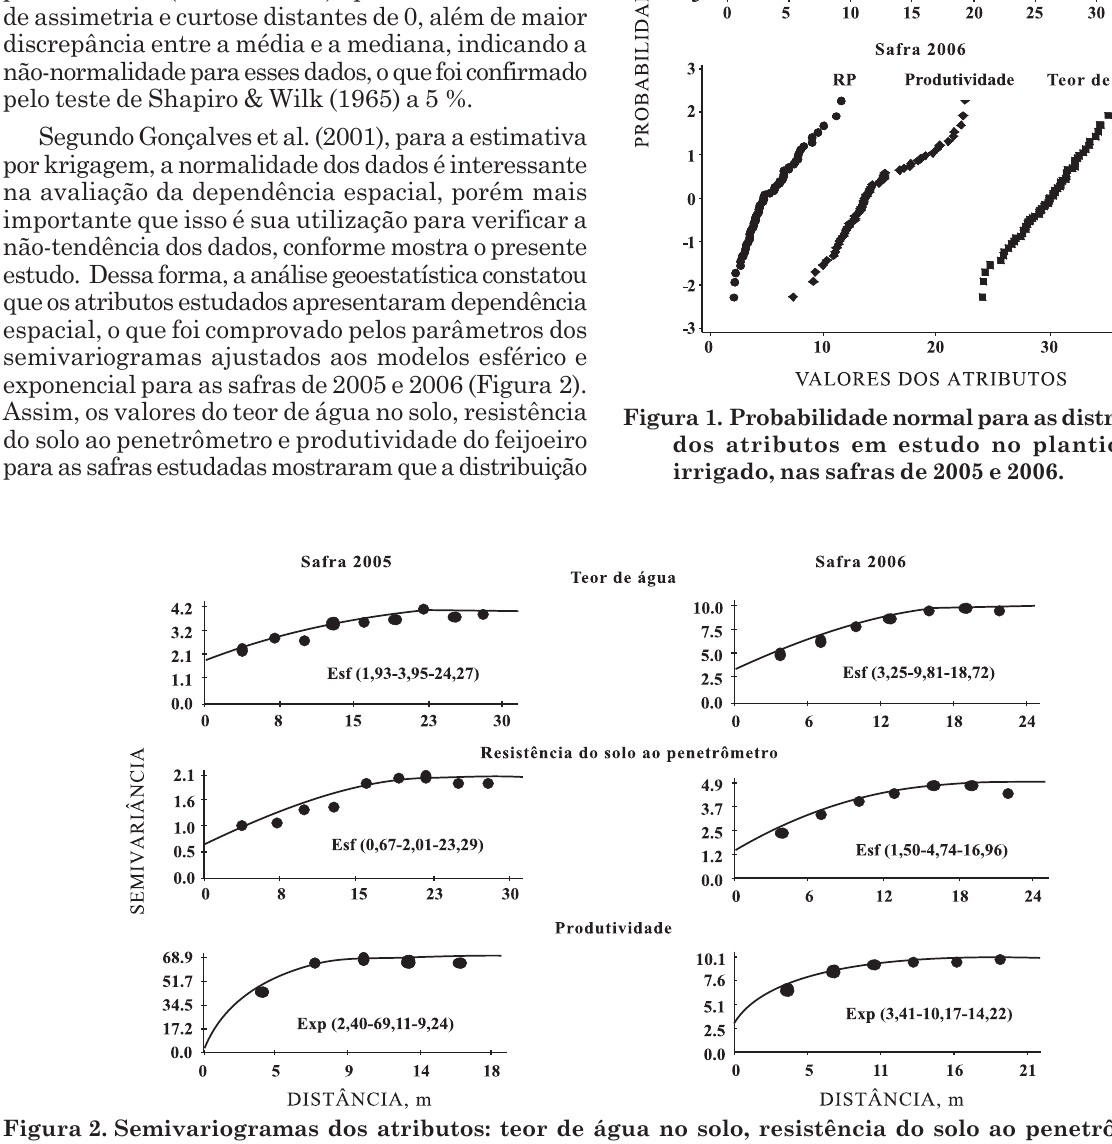
: efeito pepita; C +C 0 0 1: